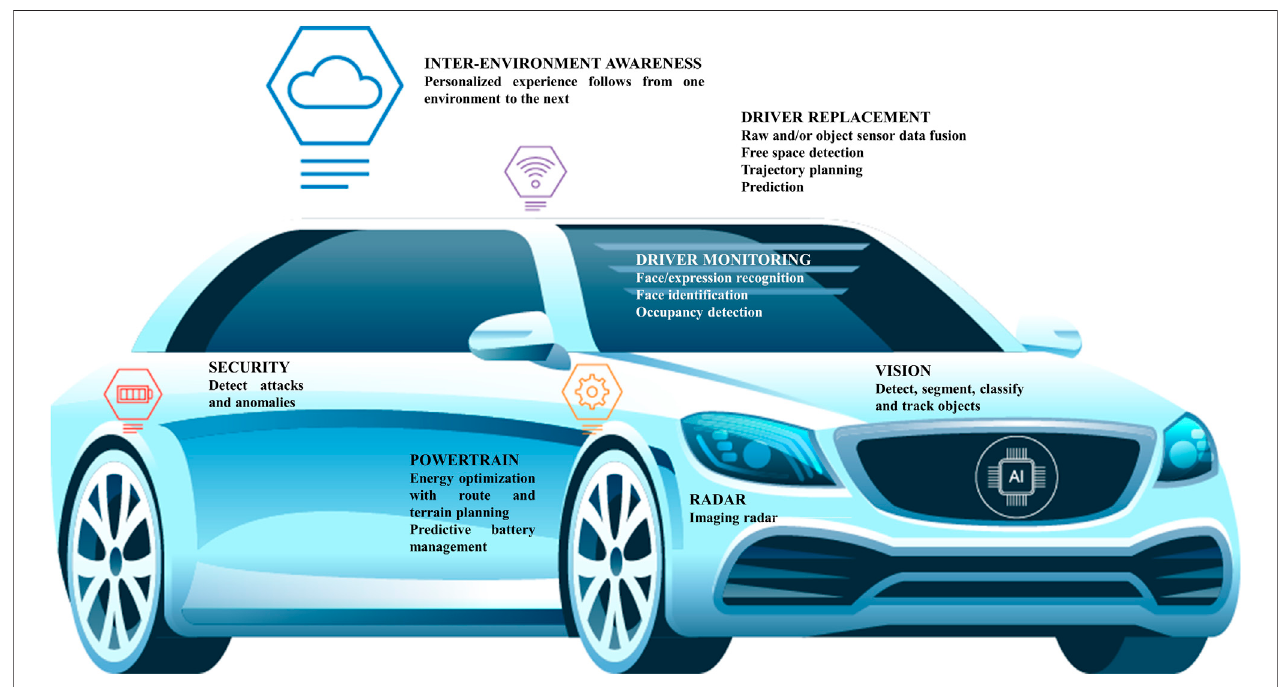
FIGURE 13 | AI role in ECAS